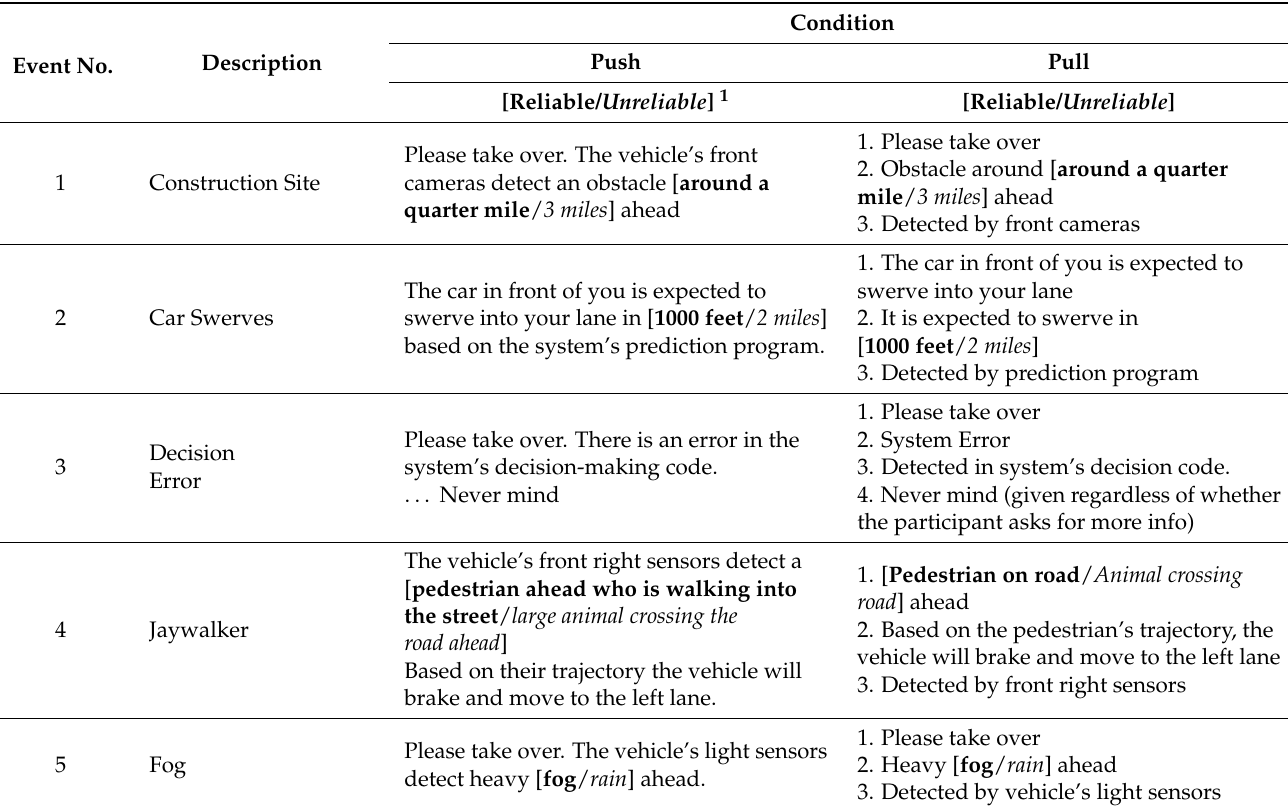
Table 1. Scenario 1 Intervention